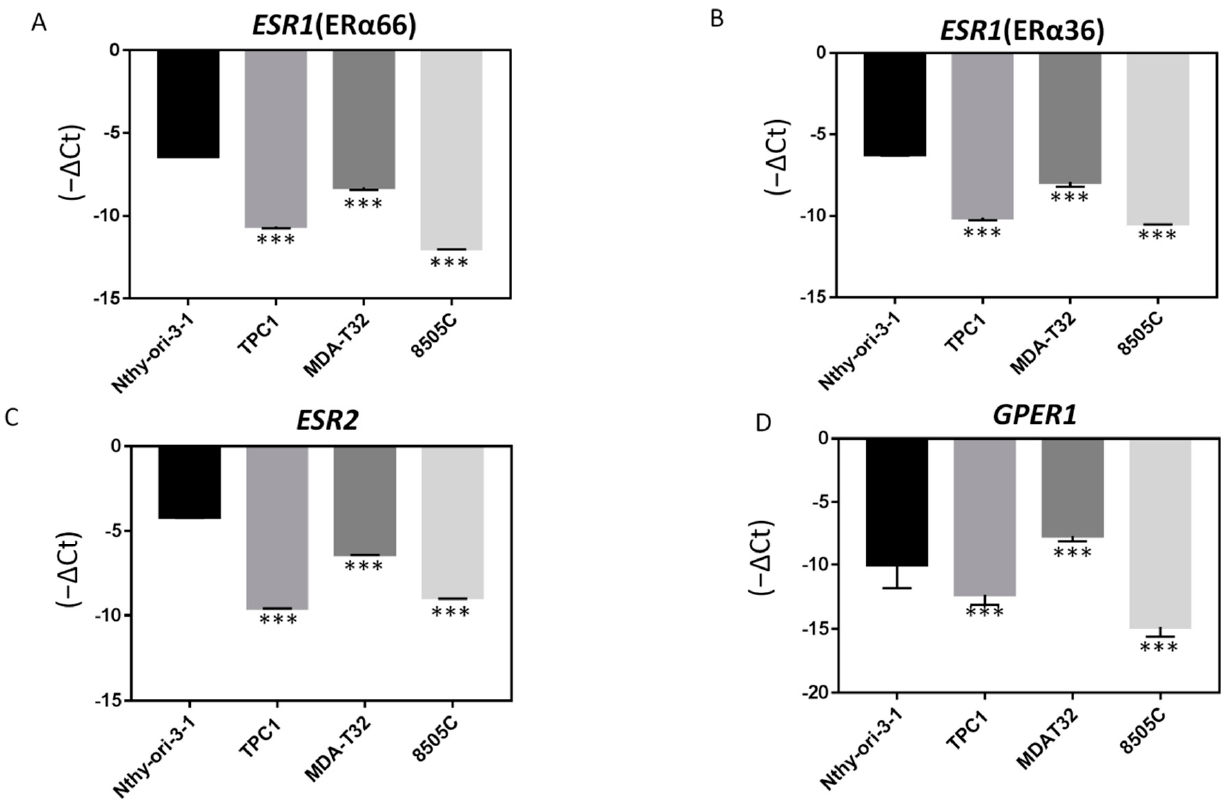
Figure 4. Endogenous ER mRNA expression levels are higher in PTC-derived cancer cells than in normal thyroid cells. The mRNA expression level of ( A ) ER α 66, ( B ) ER α 36, ( C ) ER β , and ( D ) GPER1 in the normal thyroid cell line, Nthy-ori-3-1, is higher than that in PTC-derived cancer cell lines (TPC1 and MDAT32) and the ATC-derived cancer cell line (8505C); *** p < 0.001 compared with normal thyroid cells.